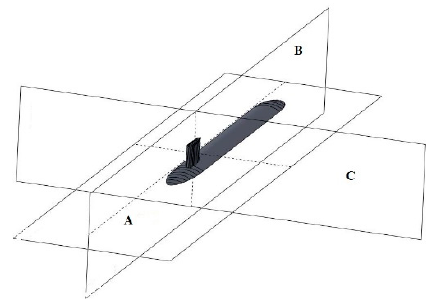
Figure 4. Diagram of the reference planes. Plane A is in the longitudinal direction, plane B is also in the longitudinal direction, which is perpendicular to plane A, and plane C is in the transverse direction.